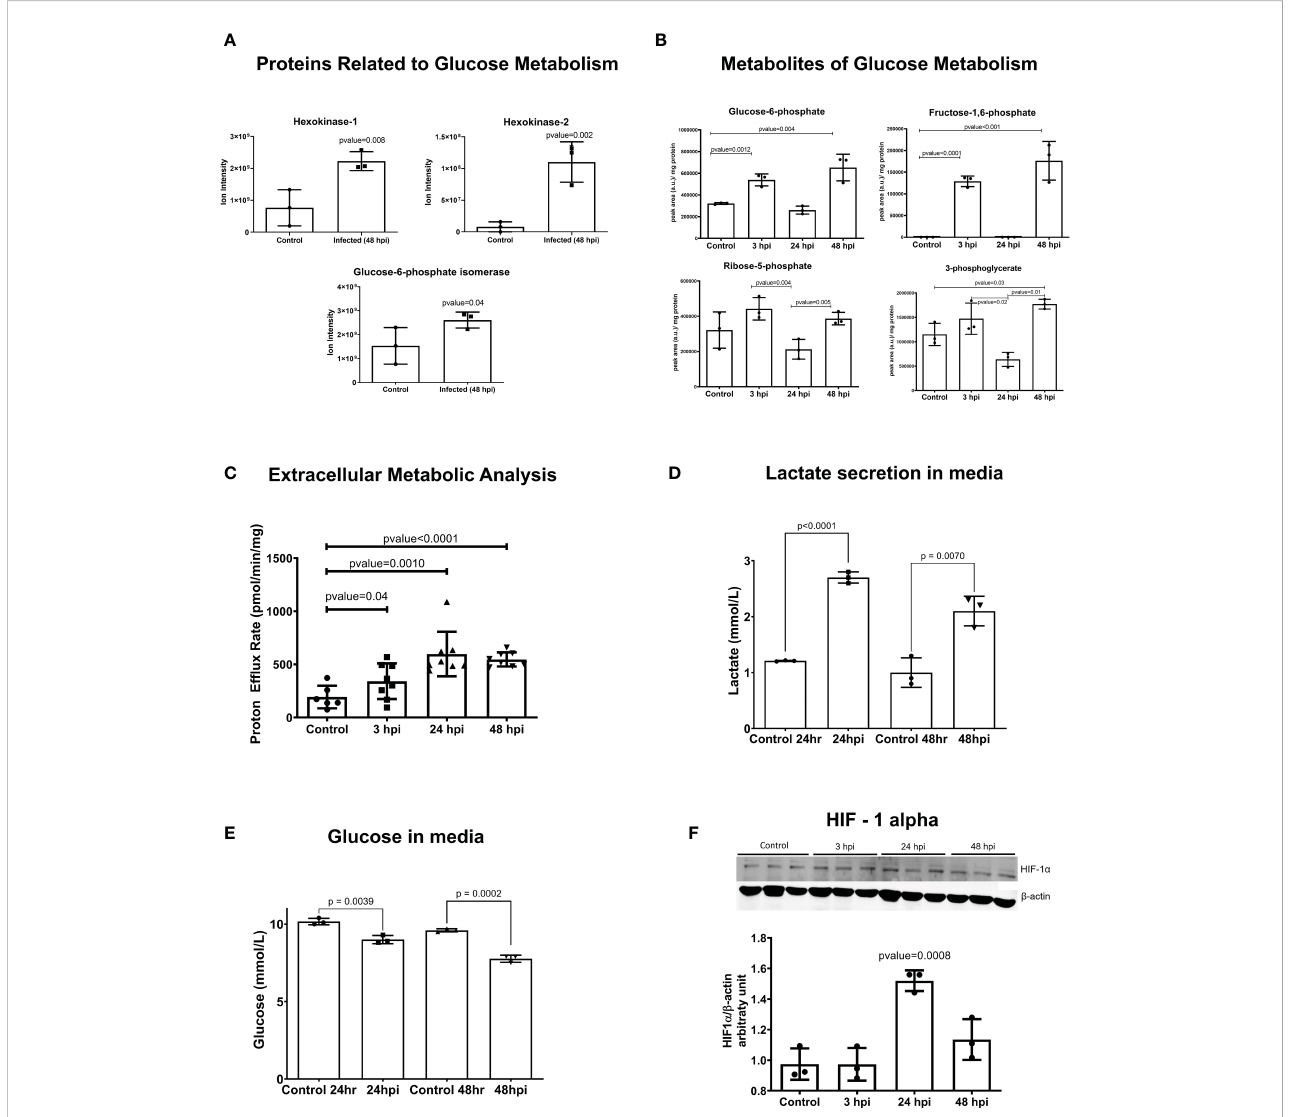
FIGURE 2 Glycolysis is activated in iPSC-CMs after T. cruzi infection. (A) Mass spectrometry (Ion Intensity) demonstrate increased levels of key metabolic regulatory enzymes (hexokinase 1 (HK1), hexokinase 2 (HK2) and glucose-6-phosphate isomerase (GPI). (B) Intermediate metabolites of glycolysis are increases at 3 hpi, demonstrating an early glycolytic switch after infection. (C) Extracellular metabolic fl ux analysis shows proton ef fl ux rate in infected IPSC-CMs. (D) Lactate secreted in the media after parasite infection. (E) Glucose concentration in media showing the consumption after parasite infection. (F) HIF- 1 a protein is increased in iPSC-CMs at 24 hpi, consistent with transcriptomic data. Data re fl ect three independent replicates for each experiment. Statistical analyses used ANOVA test with Bonferroni correction or t - test when appropriate and p-value<0.05 was considered signi fi